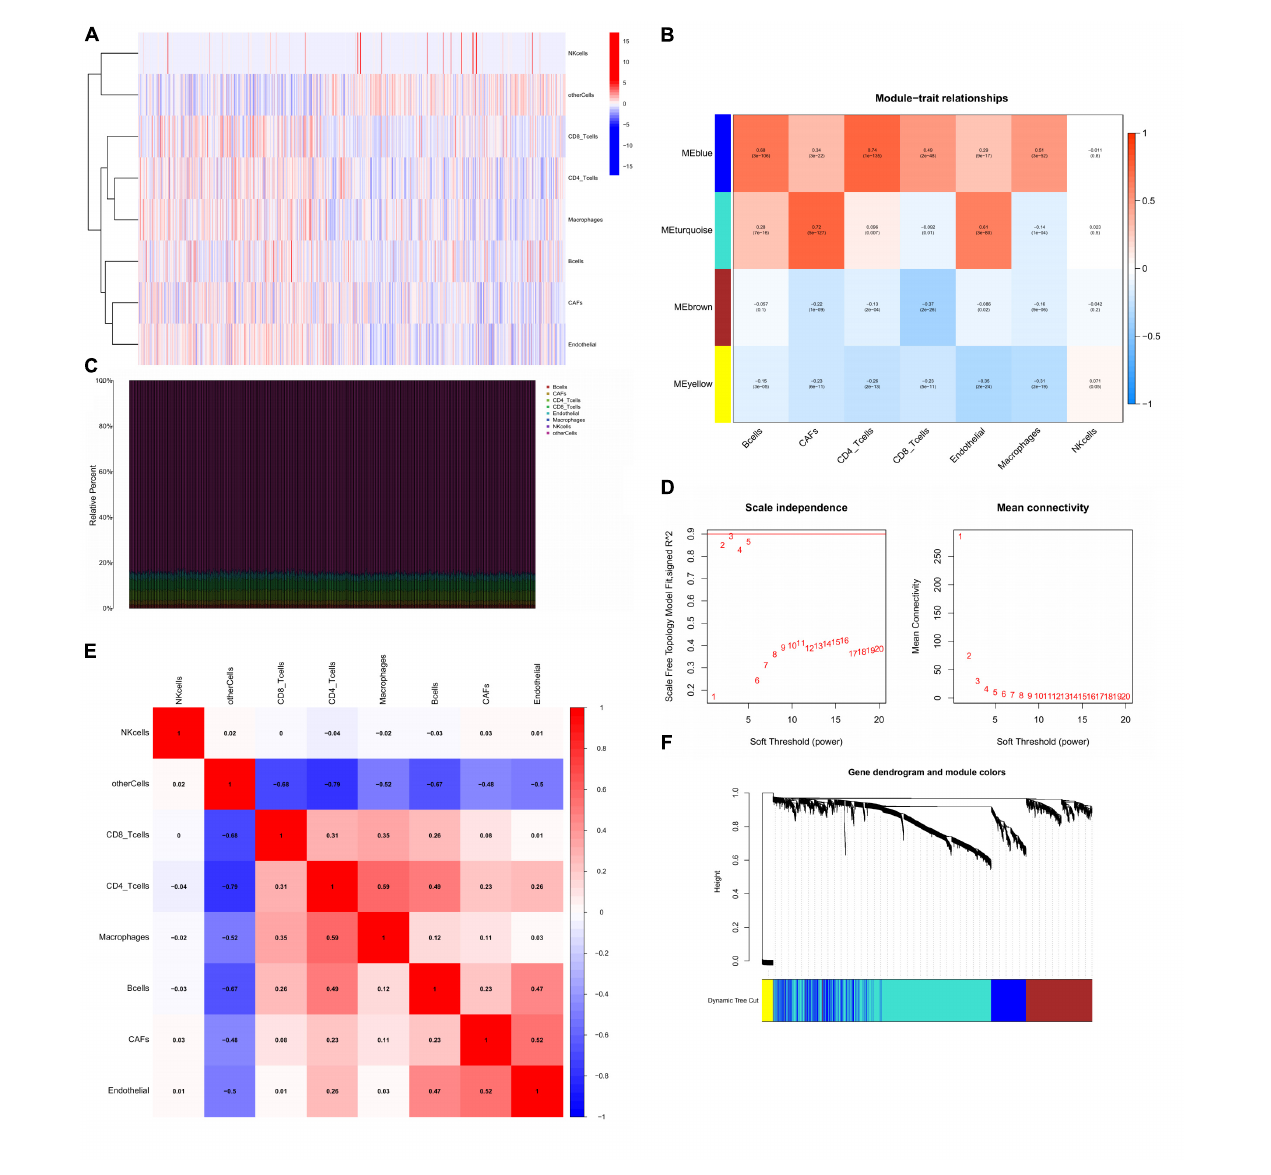
FIGURE6 Identification of CAFs-related module from comparing HP-infection related subtypes. (A) The display of the expression status of different cells in GC. (B) Heatmap showing the relationship between GC traits and ME. Correlation coefficients and P -values were showed in each kind of cells. (C) Stacked bar plot showing the percentage of various cells, and cell fractions estimated by EPIC. (D) Identification of soft-threshold power through analyzing the value of mean connectivity and scale-free index. (E) The correlation matrix of eight types of GC sample cells. Coefficients were labeled. (F) Plot of gene dendrogram presenting the module assignment with the help of average linkage hierarchical clustering. CAFs, cancer associated fibroblasts; GC, gastric cancer; ME, module eigengenes; EPIC, estimating the proportions of immune and cancer cells.